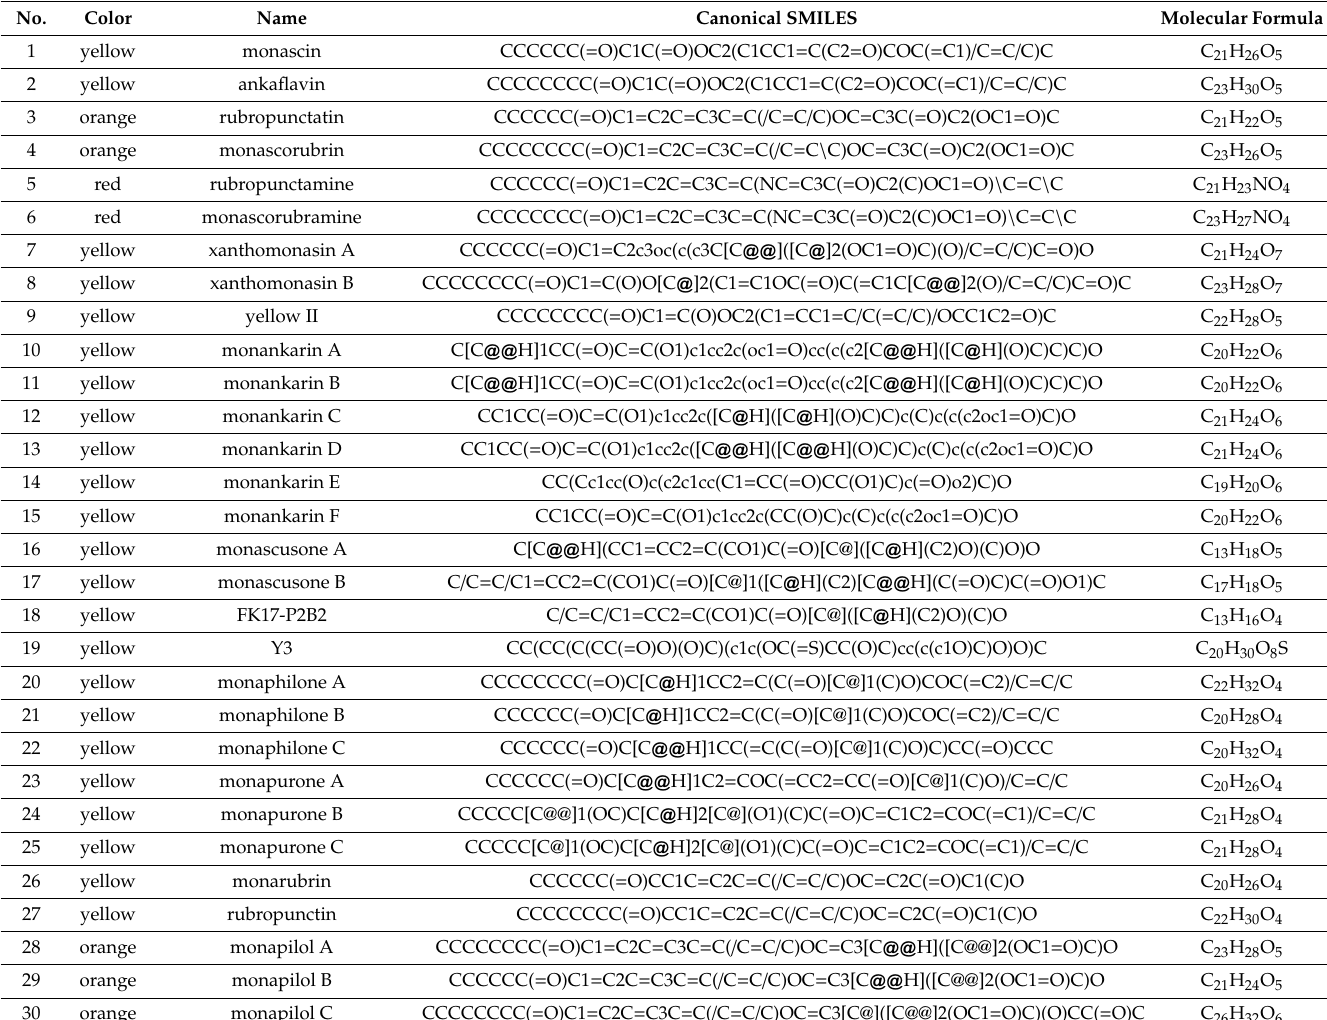
Table 1. Chemical structures of the 61 Monascus pigments (MPs) used in this